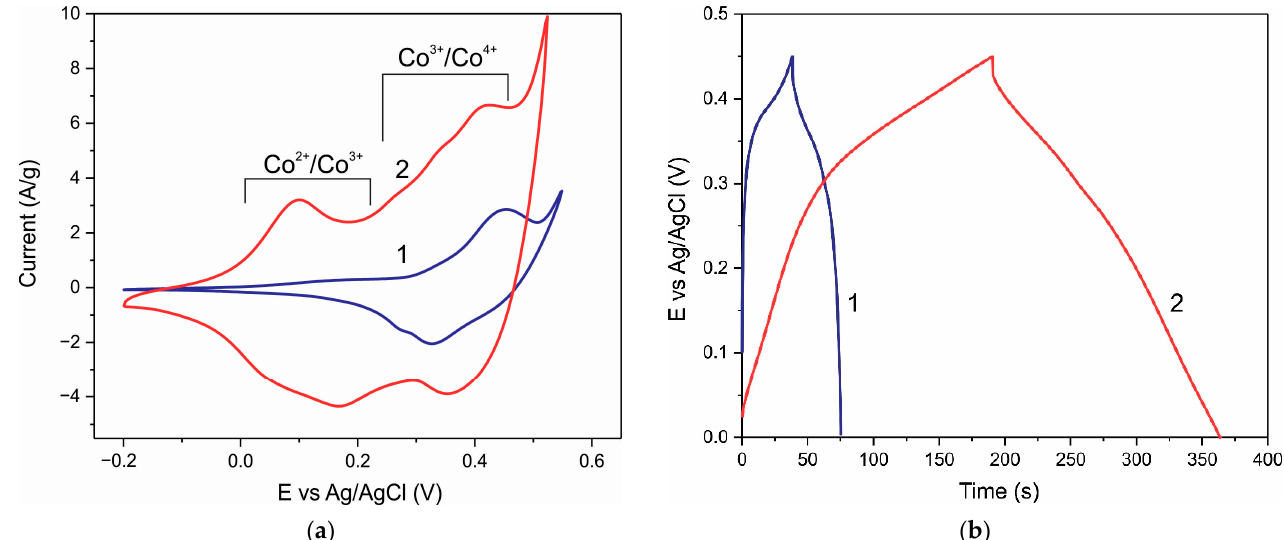
a wide range of active redox sites are created during H2-treatment.